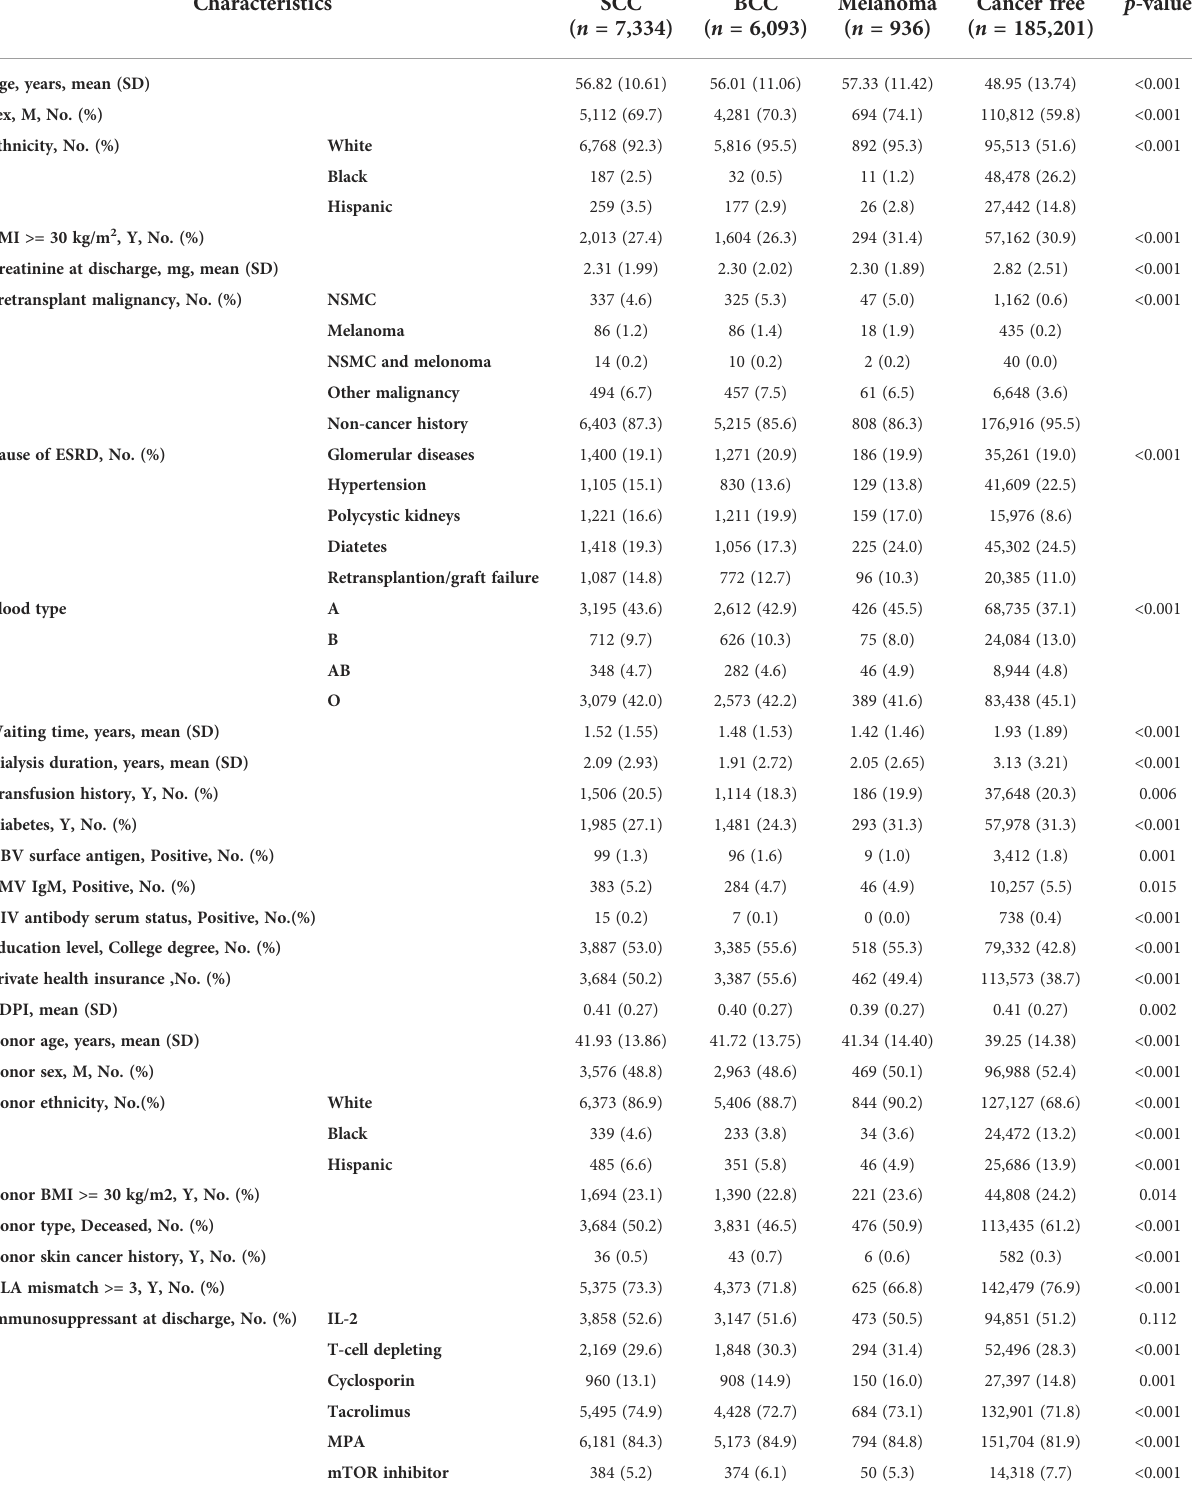
TABLE 1 Characteristics of recipients and donors.